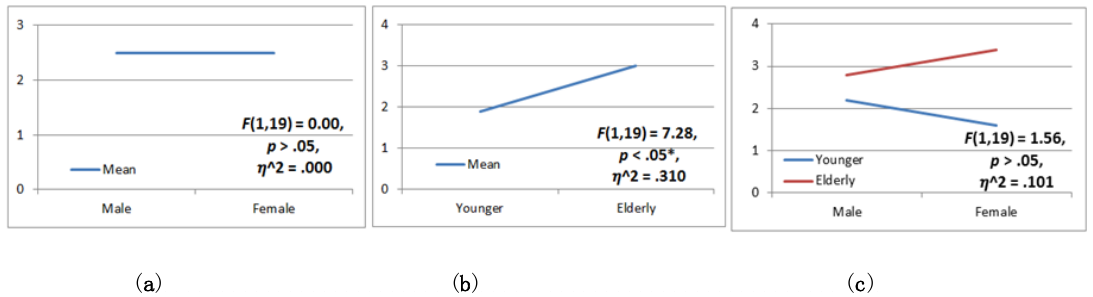
Figure 7. Visual attention transitions between map and landmark: ( a ) gender differences, ( b ) age differences, and ( c ) gender and age cross differences.